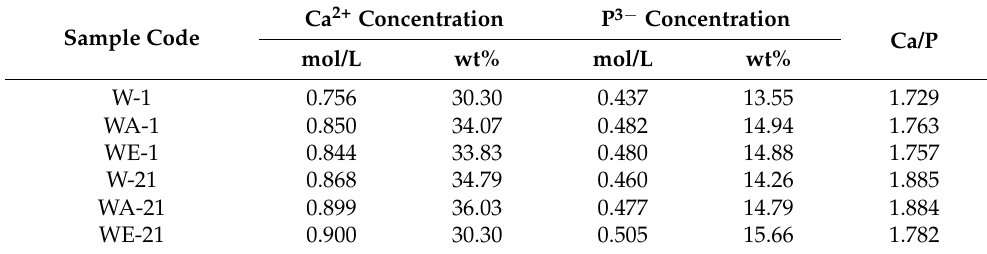
Table 1. Chemical compositions of the